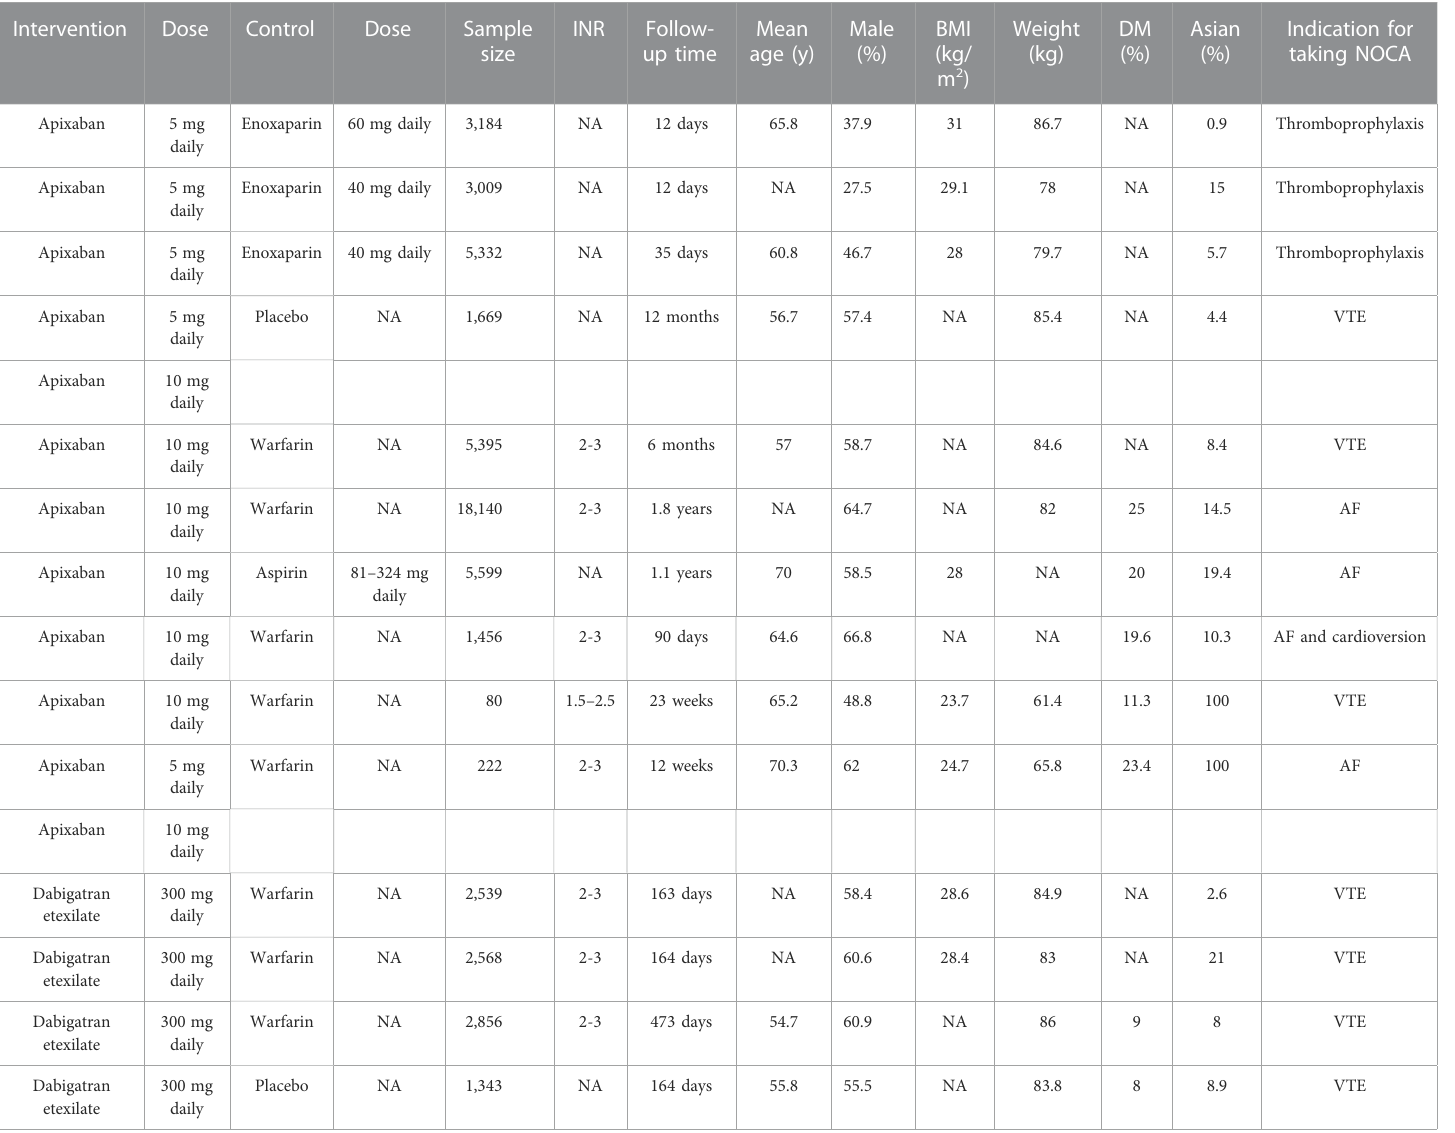
TABLE 1 Characteristics of the included studies and populations.